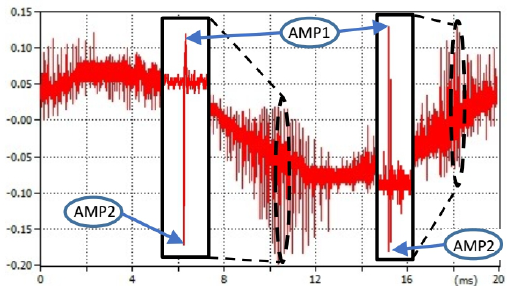
Figure 4. Visualization of PD pulse detail during line to ground fault.